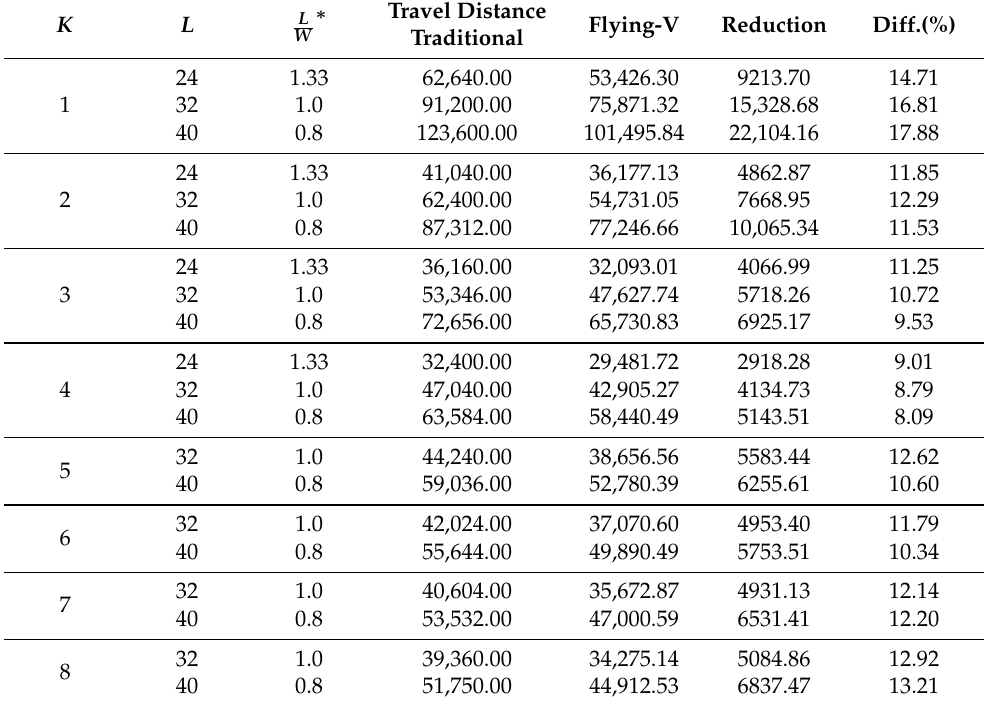
Table 13. Total distance comparison ( L =